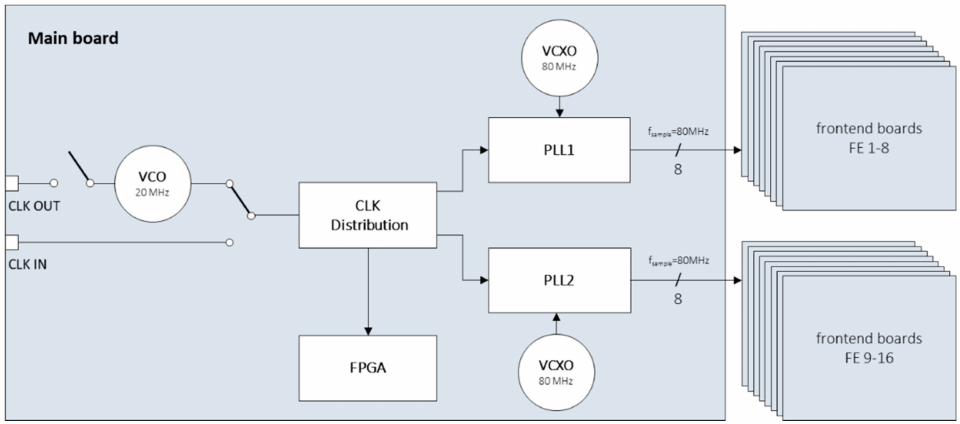
Figure 3. Circuit for internal clock generation of each 256-channel